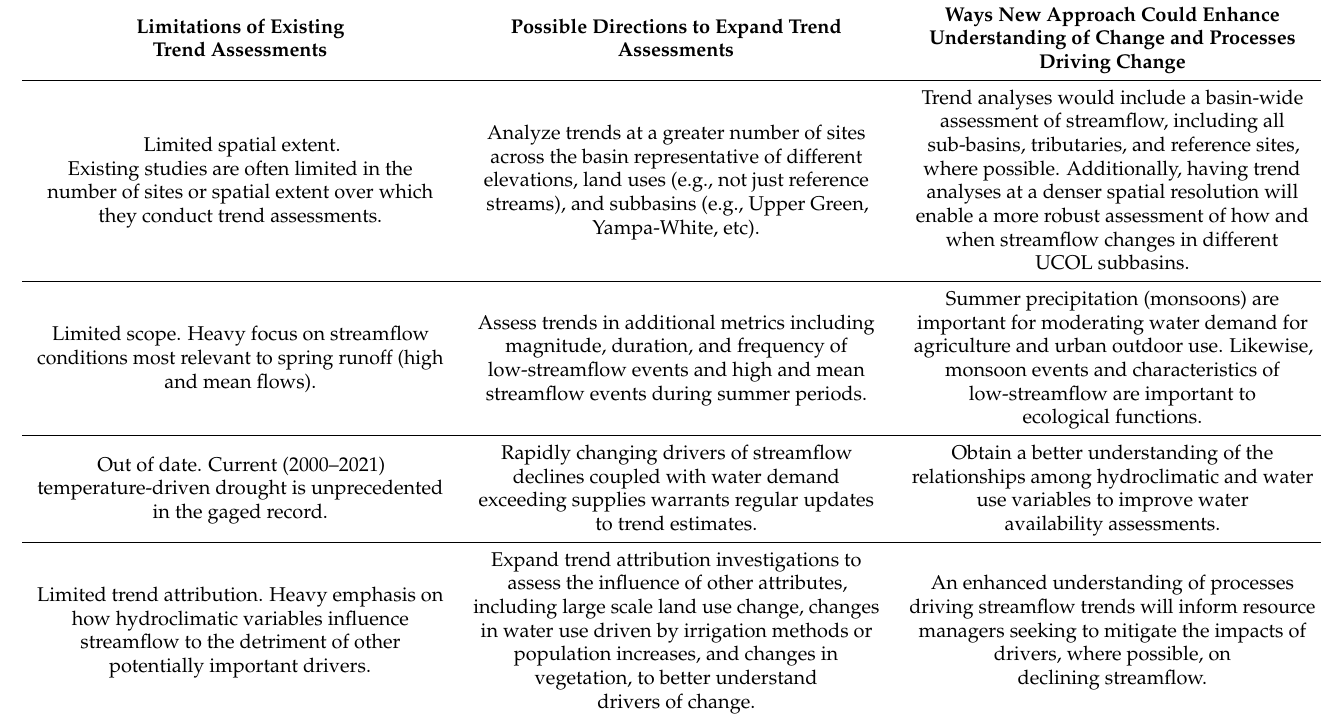
Table 2. Limitations of existing streamflow trend assessments and opportunities for new water availability